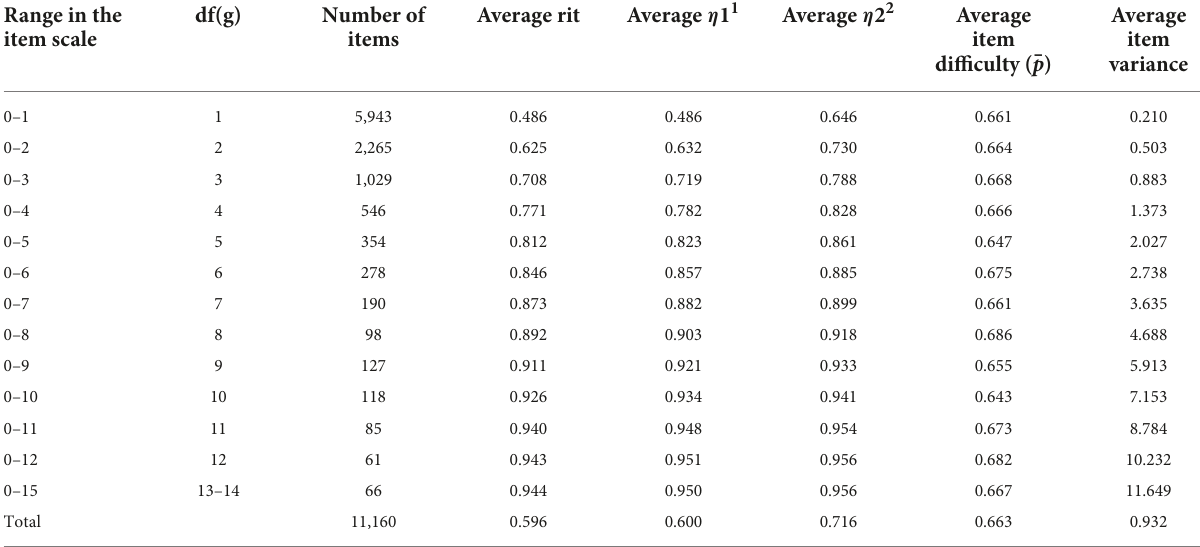
TABLE 2 Selected characteristics of 11,160 items in comparison.